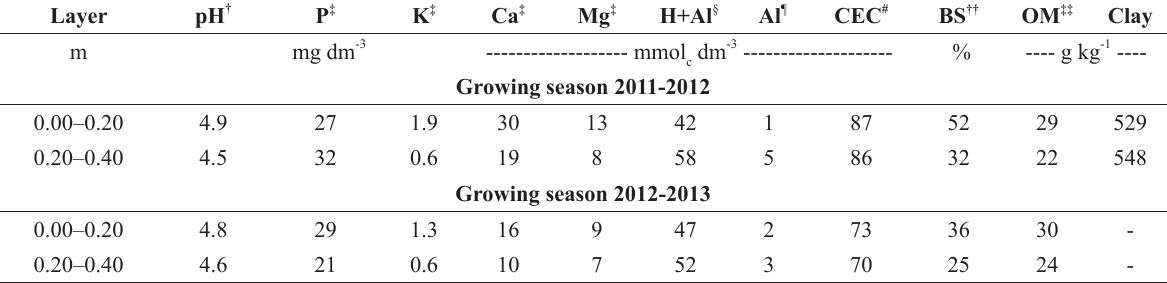
Chemical characterization and clay content of the experimental area. Piracicaba (SP),